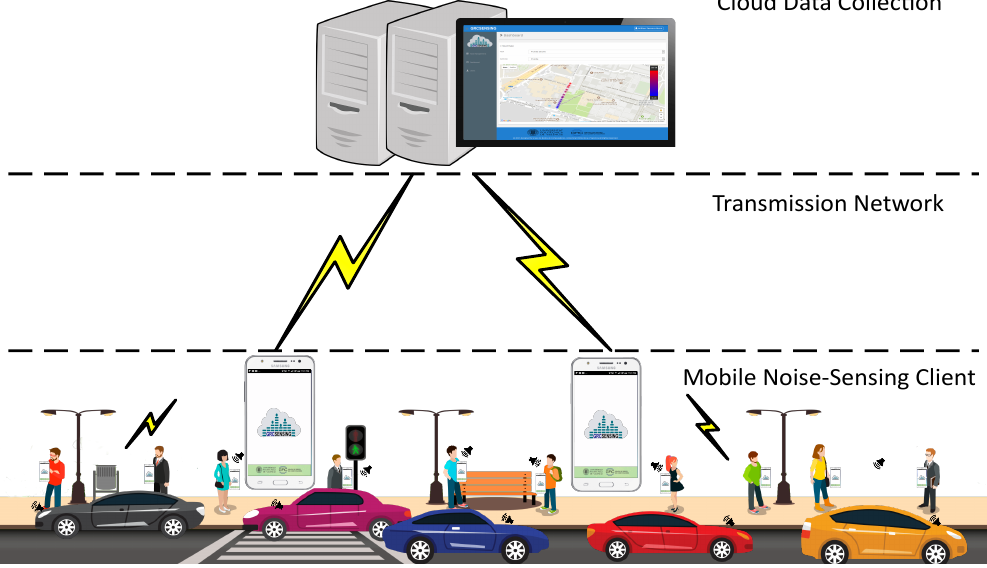
Figure 1. General architecture for noise assessment based on